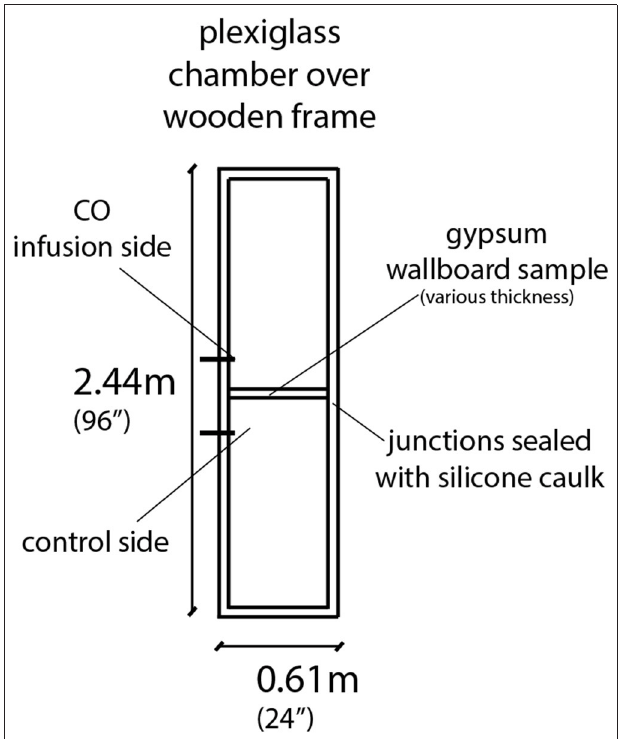
FIGURE 1 | Sketch of experimental setup used in Hampson et al. (2013).